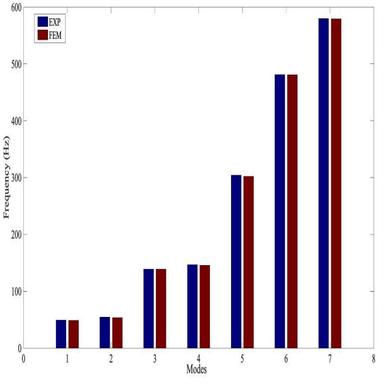
Frequency comparison of experimental and FEM .